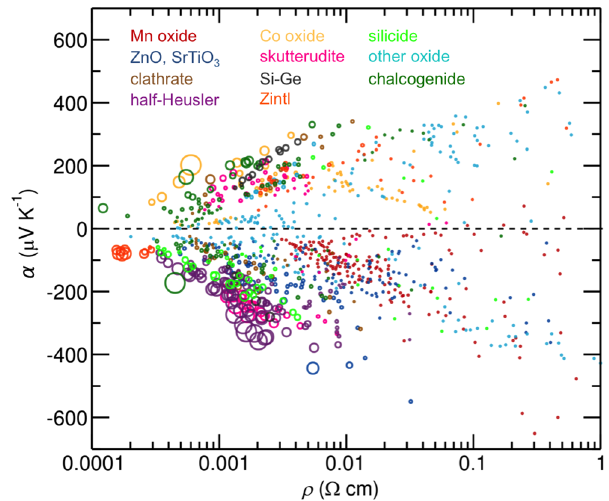
Figure 2. Transport properties of thermoelectric compounds reported to date, organized by class of compound. Marker radius is proportional to the reported power factor. Figure adapted from work by Gaultois et al.